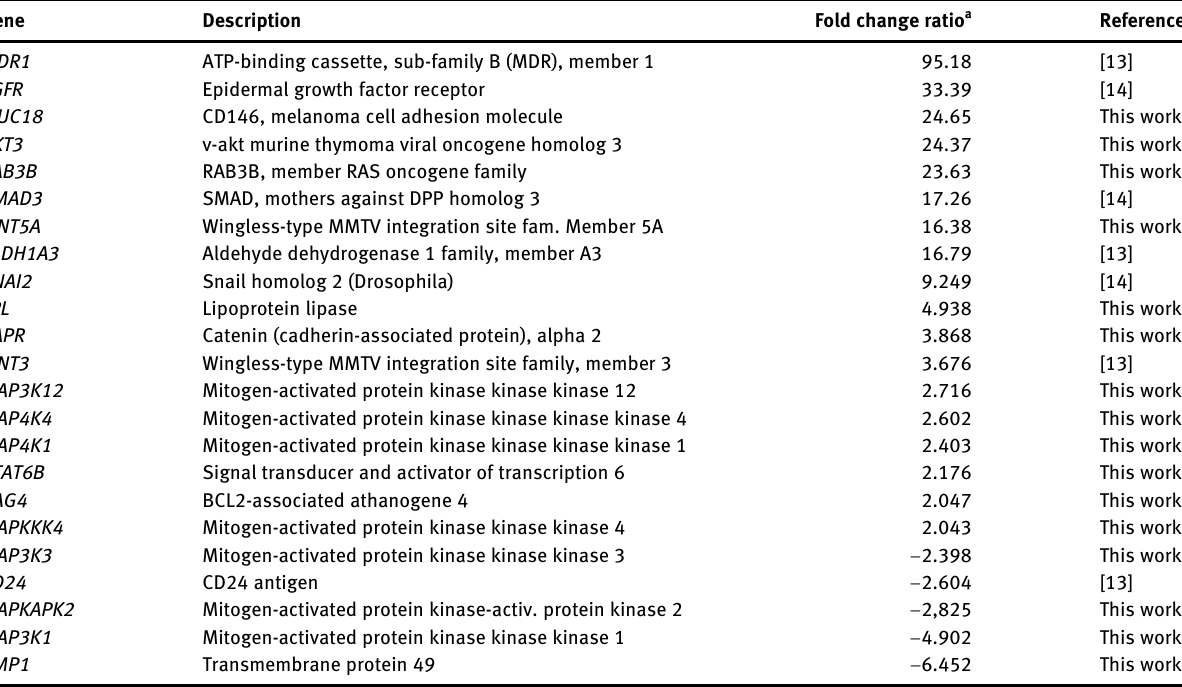
Table  : Whole genome cDNA microarray analysis of the drug resistance related genes in drug resistant BCSCs with respect to drug sensitive BCCs.